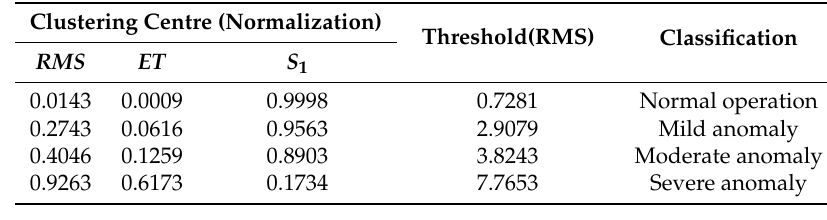
Table 6. Historical data clustering centres and thresholds.